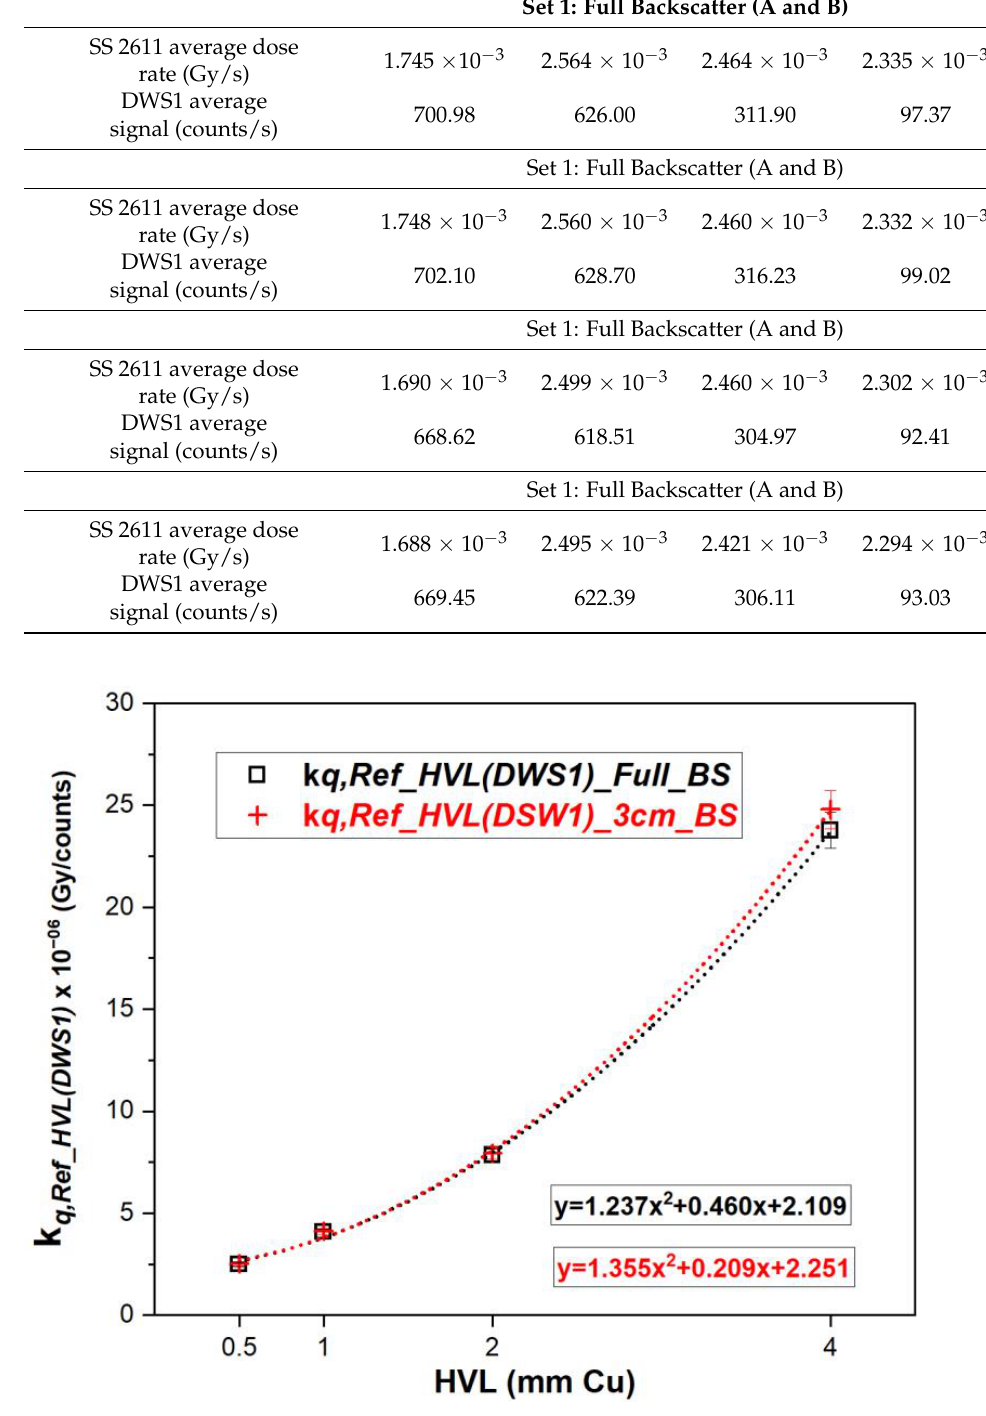
Table 3. Measurements recorded during the DWS1 cross-calibration at NPL 300 kV facility.